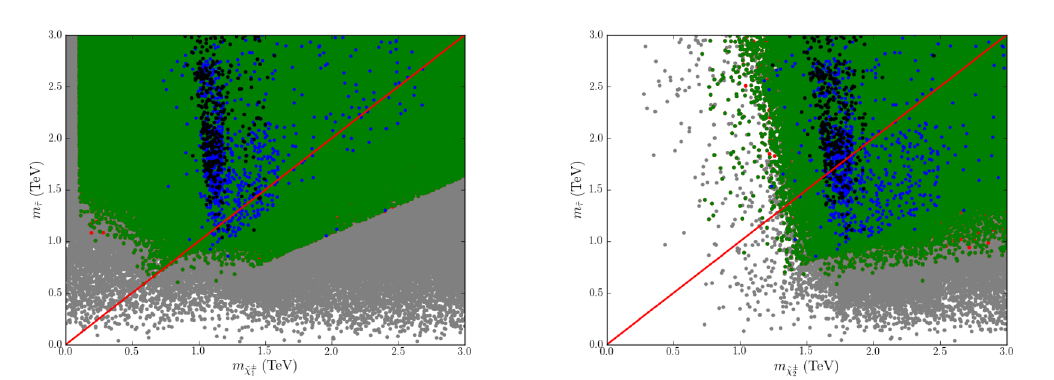
Figure 5 . The mass spectrum of the chargino versus stau over the following planes: ( m , m ˜ τ ) ˜ χ ± 1 (left), ( m , m ˜ τ ) (right). Our colour convention is as listed at the end of section 3. ˜ χ ± 2 panels, the diagonal solid red lines indicate regions in which the displayed parameters are degenerate in value. The top left panel shows that the lightest neutralino, which are our DM candidate, versus the lightest chargino. The mass of DM consistent with Yukawa unification can be in a narrow range as 0 . 6 TeV . m . 1 . 3 TeV while the lightest chargino ˜ χ 0 1